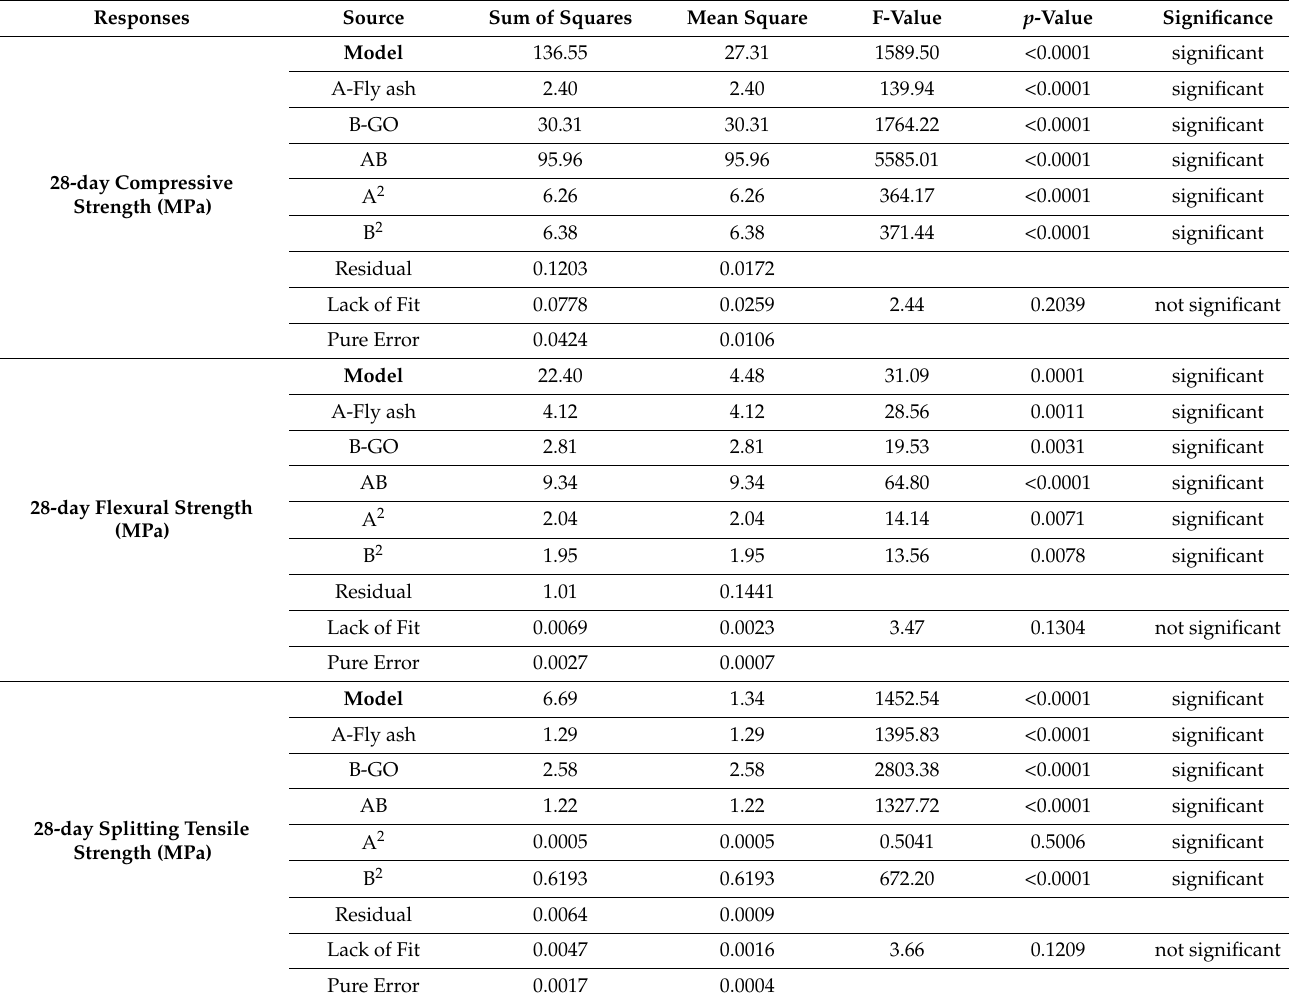
Table 8. ANOVA fit summary for mechanical strength